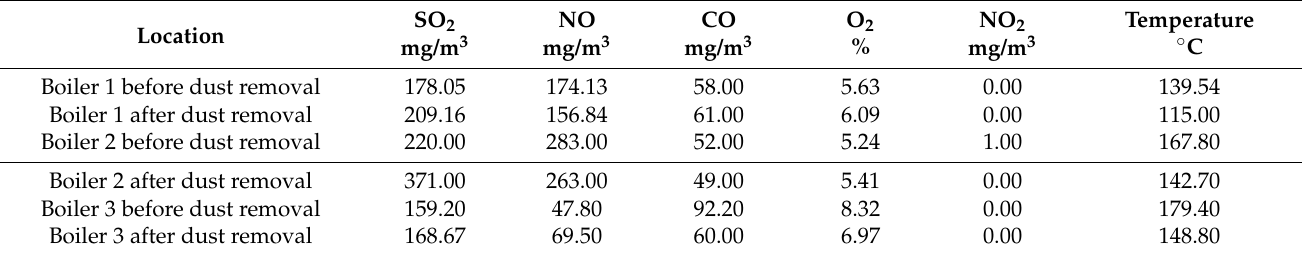
Table 3. Flue gas analysis results.